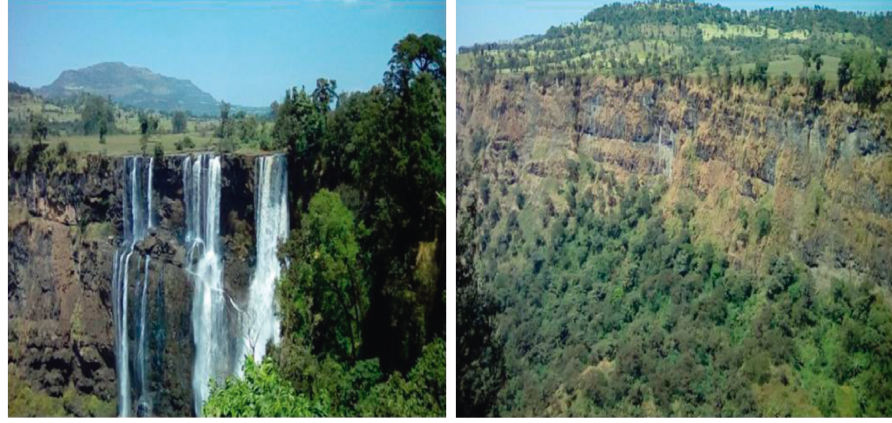
Figure 2: Partial view of Tiski